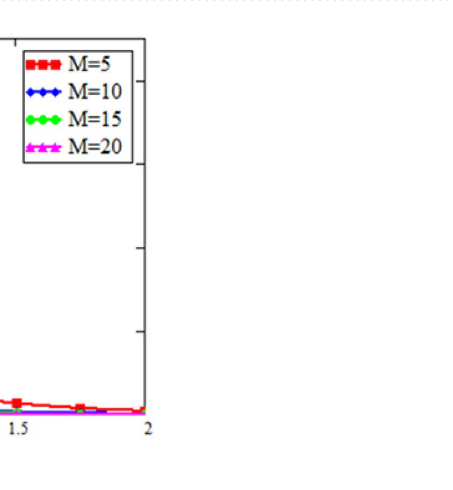
Figure 10. Velocity and temperature profiles in comparison to the results in 16 .